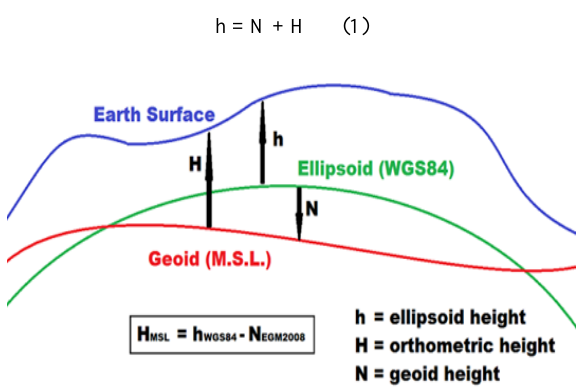
Figure 4. The schematic diagram of height conversion